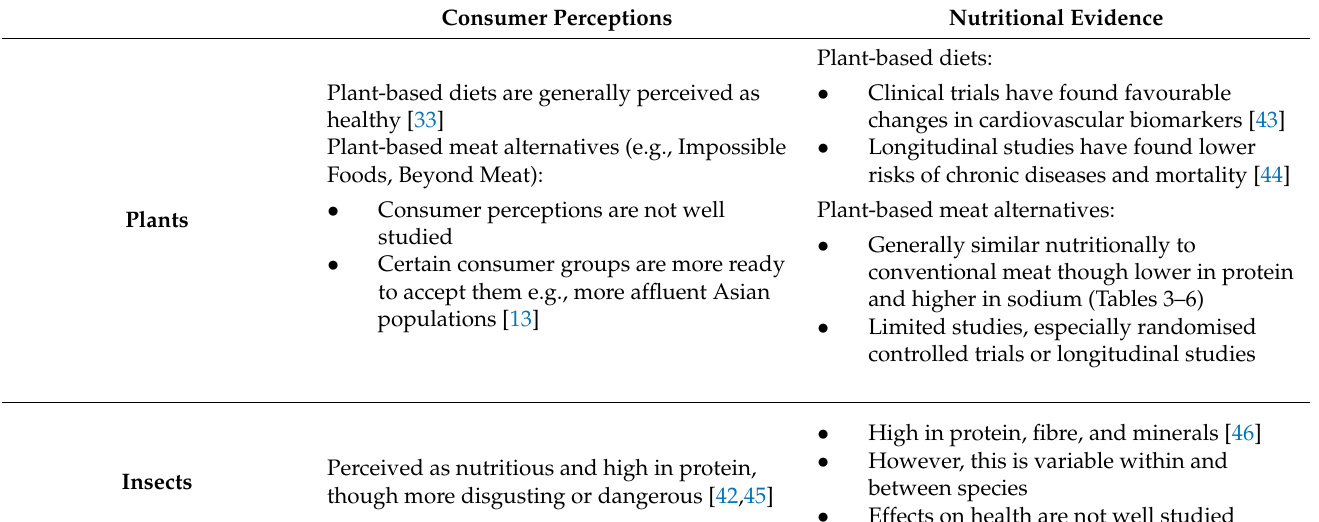
Table 2. Consumer perceptions and available evidence on the nutritional quality of alternative